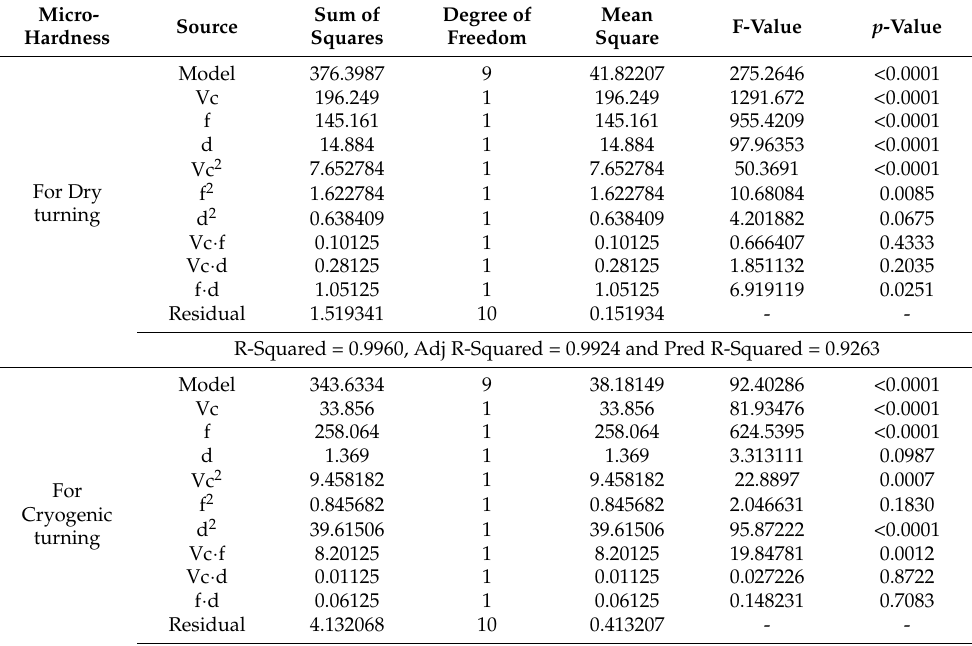
Table 7. ANOVA table for micro-hardness. Micro- Hardness